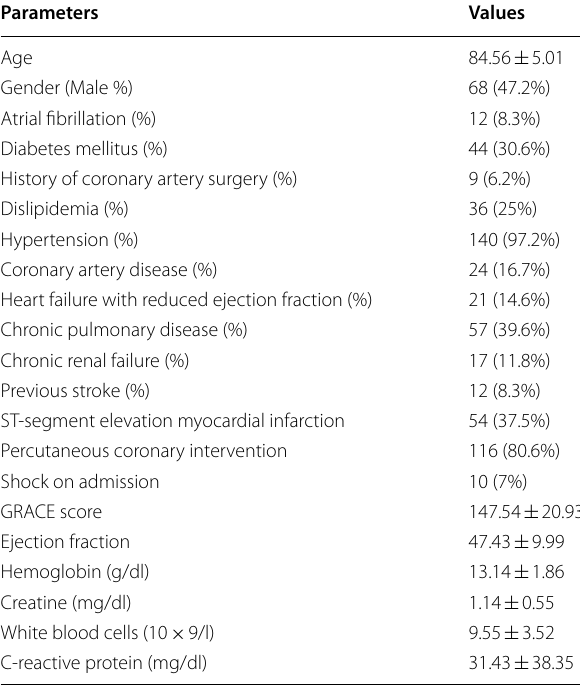
Table 2 Angiographic and follow-up data